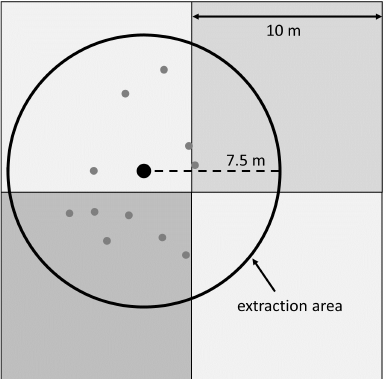
Figure 5. Exemplary extraction area of 176.7 m 2 with the four relevant 10 m × 10 m pixels of synthetic aperture radar (SAR) data depicted in the background: the center of the circle represents the centroid of the observation points of all dates (grey